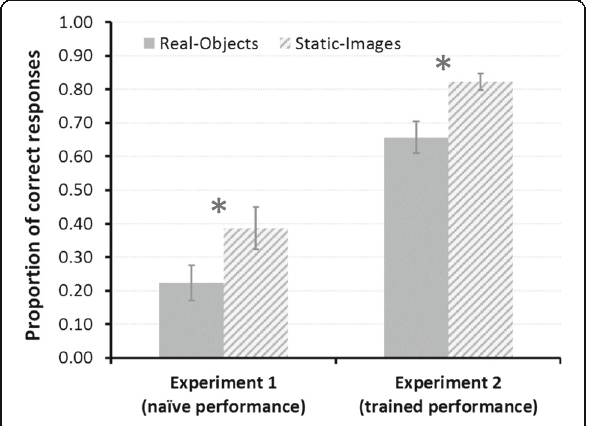
Fig. 3 Proportion of correct responses on trials for which the faster object in a pair was small and light (see Panel 5 in Fig. 1). Results are separated by experiment and condition. * p <